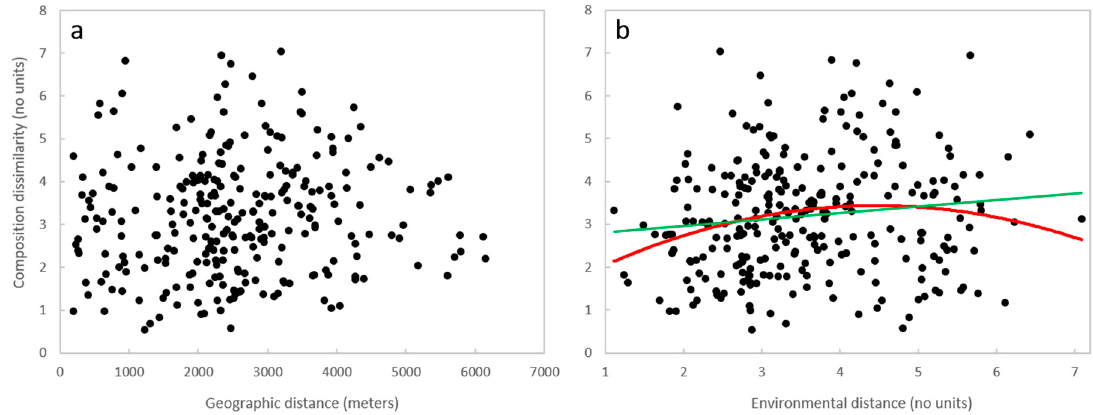
Figure 4. Relationships between geographic distance and composition dissimilarity ( a ), linear fit: R 2 = 0.0048, p = 0.246, n = 276) and between geographic distance and composition dissimilarity ( b ), linear fit in green: R 2 = 0.0162, p = 0.034; binomial fit in red: R 2 = 0.033, p = 0.001, n = 276). Each point represents a pairwise lake distance (either geographic or environ- mental).